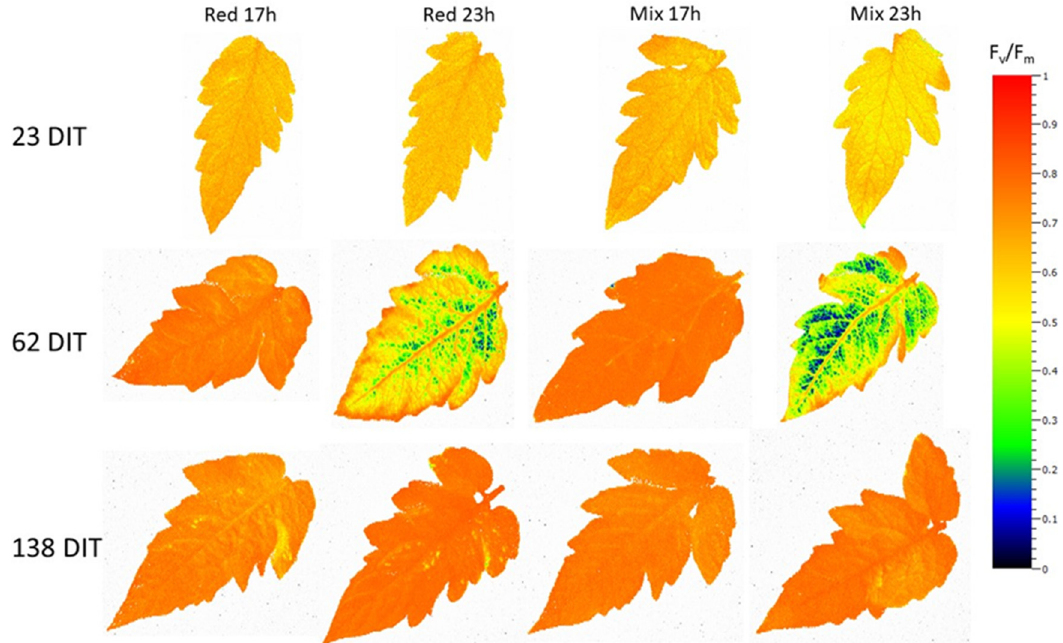
Figure 4. Spatial response of F v /F m from the 5th leaf of TE tomatoes grown under either red 17 h, red 23 h, mix 17 h, or mix 23 h lighting treatments at 23 DIT (December 8, 2018), 62 DIT(January 16, 2019), and 138 DIT (April 2, 2019).